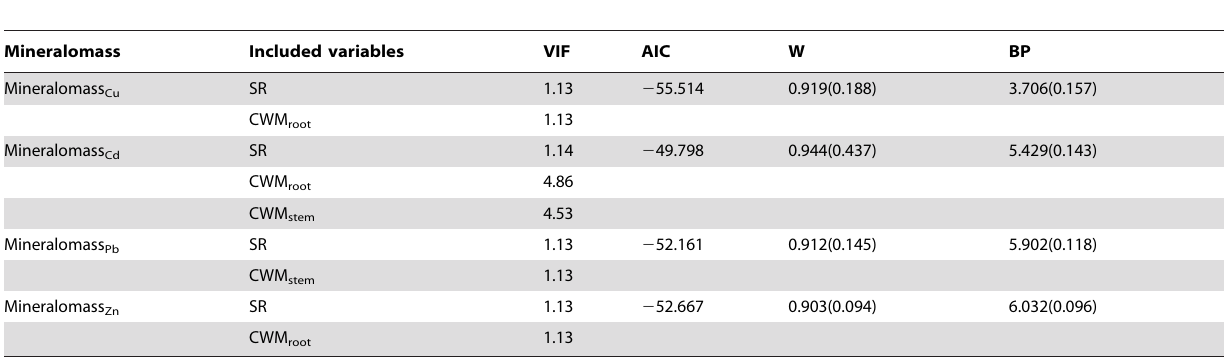
Table 3. Multiple stepwise regression analyses between mineralomass and explanatory variables from a model that initially contained four variables (actual species richness (SR), FD Q , CWM root and CWM stem values for Cu, Cd, Pb and Zn).